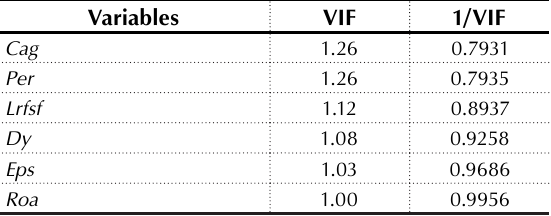
Table 5. Pairwise Correlation Matrix (Value Stock Portfolio)